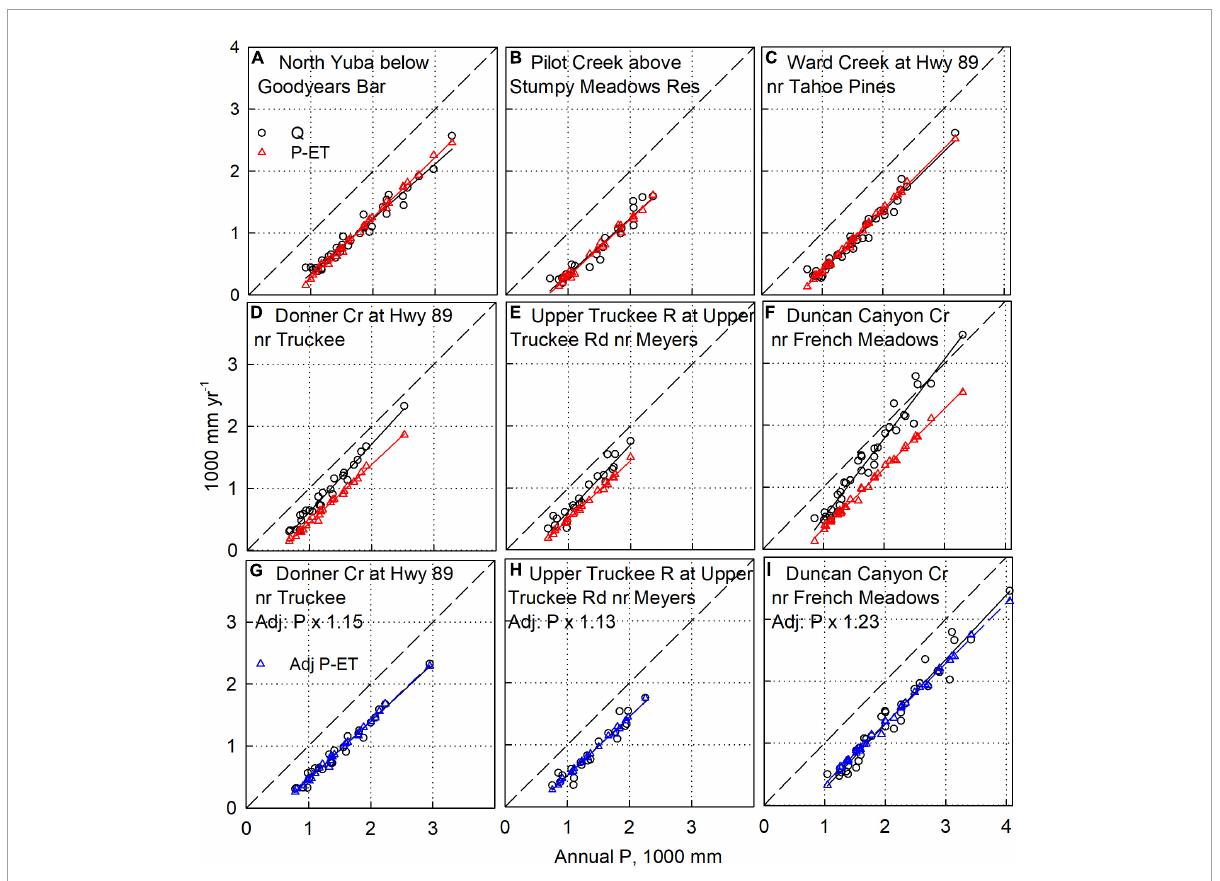
FIGURE3 Water-balance analysis on representative watersheds. (A–C) Have no adjustment to P , ET, or Q values, and show average agreement between P-ET and Q within 2%. (D–F) Also have no adjustment to P , ET, or Q values, and show higher Q compared to P-ET . Thus P -values were multiplied by a constant, providing agreement between P-ET and Q (G–I) . Data for additional sites is in Supplementary Figures S1–S7 . The dashed diagonal is the 1:1